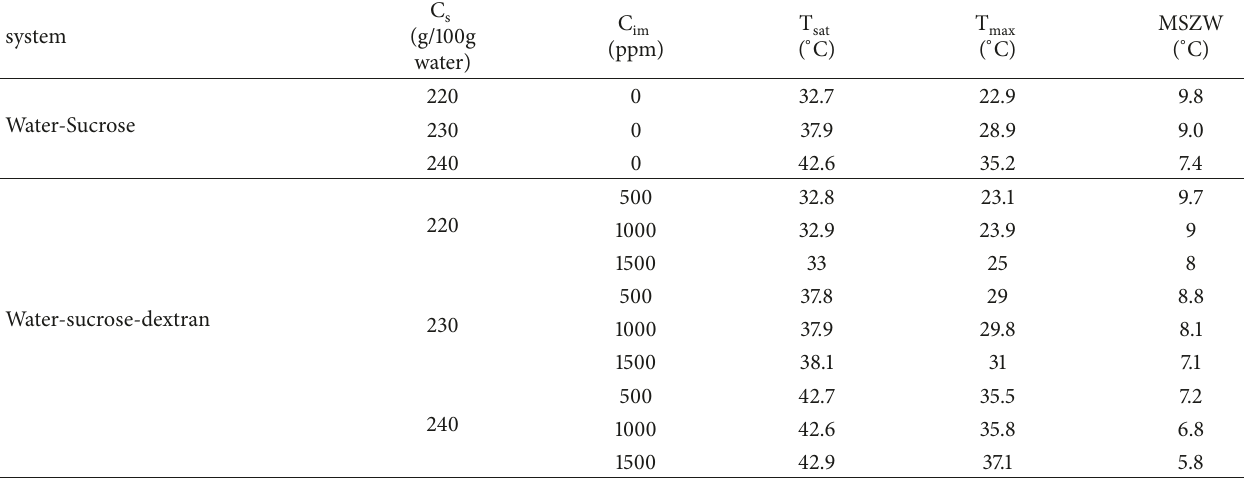
Table 1: Saturation temperature 𝑇 𝐶 containing different content 𝐶 s